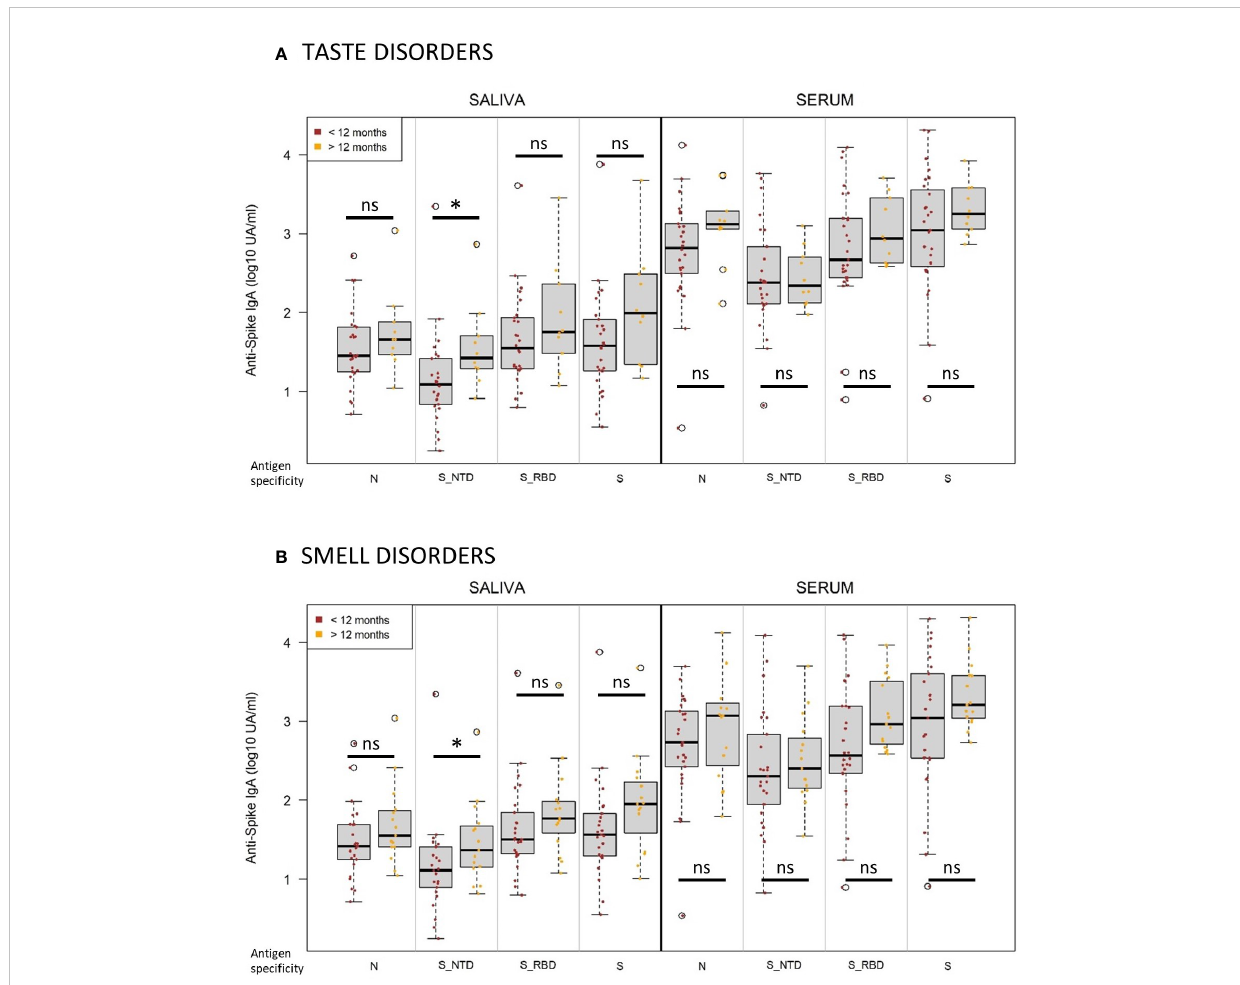
FIGURE 8 Persistent taste and smell disorders more than one year after infection are associated with higher initial titers of anti-Spike NTD IgA. (A) Normalized log-10 transformed serology titers of anti-SARS-CoV-2 IgA (log10 UA/ml) in saliva (left) and serum (right) measured at visit 1 by MSD technology from individuals suffering from taste disorders persistent for less (brown, n=28) or more (orange, n=10) than one year. (B) Normalized log-10 transformed serology titers of anti-SARS-CoV-2 IgA (log10 UA/ml) in saliva (left) and serum (right) measured at visit 1 by MSD technology from individuals suffering from smell disorders persistent for less (brown, n=27) or more (orange, n=15) than one year. Antigen speci fi city corresponds to the Nucleocapsid (N), Spike (S), Spike-receptor binding domain (S_RBD) and Spike-N-terminal domain (S_NTD). Kruskal-Wallis test: ns, not signi fi cant; *